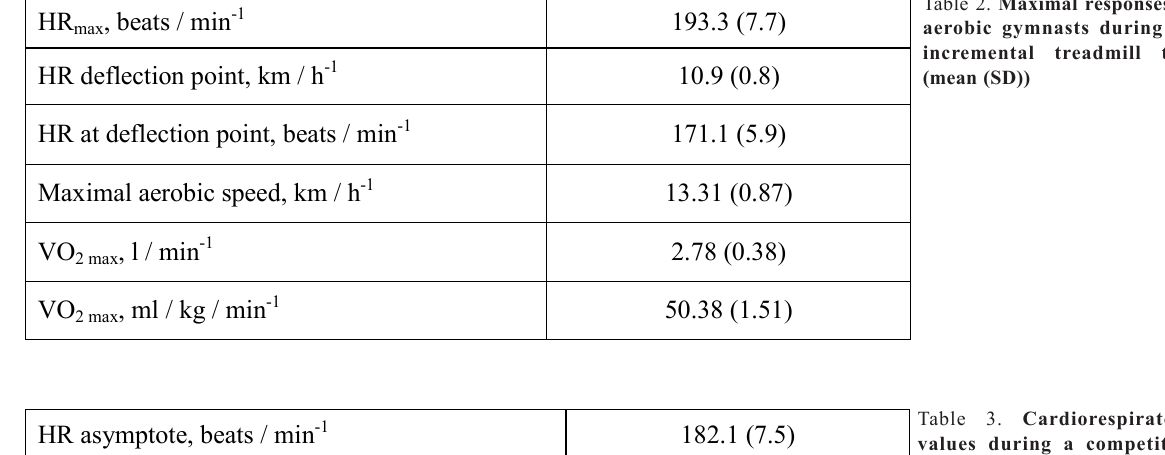
Table 3. Cardiorespiratory values during a competitive aerobic gymnastics routine (mean